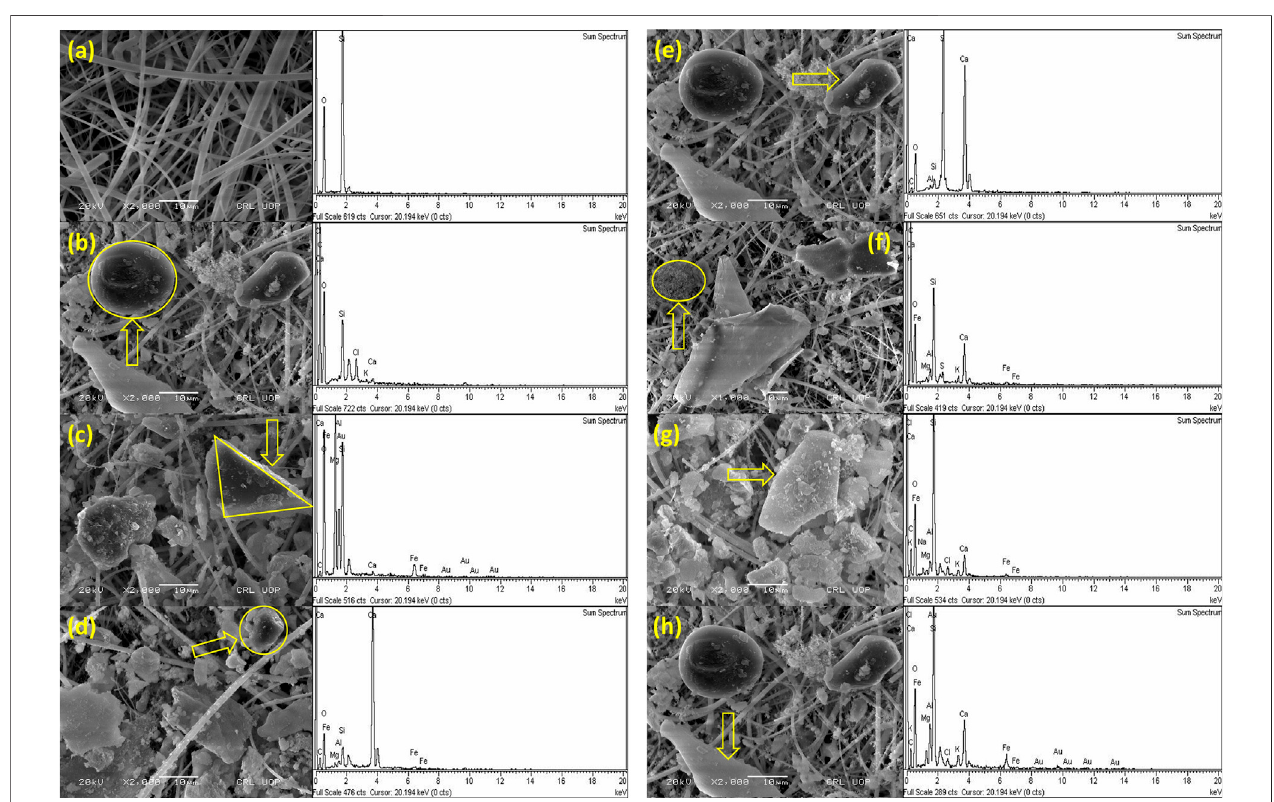
FIGURE 4 | SEM – EDX of particulates. (A) Blank fi lter, (B) carbonaceous particles, (C) aluminosilicate particles, (D) calcium-rich particles, (E) sulfate particles, (F) carbonaceous agglomerates, (G) iron-rich particles, and (H) biological particles.